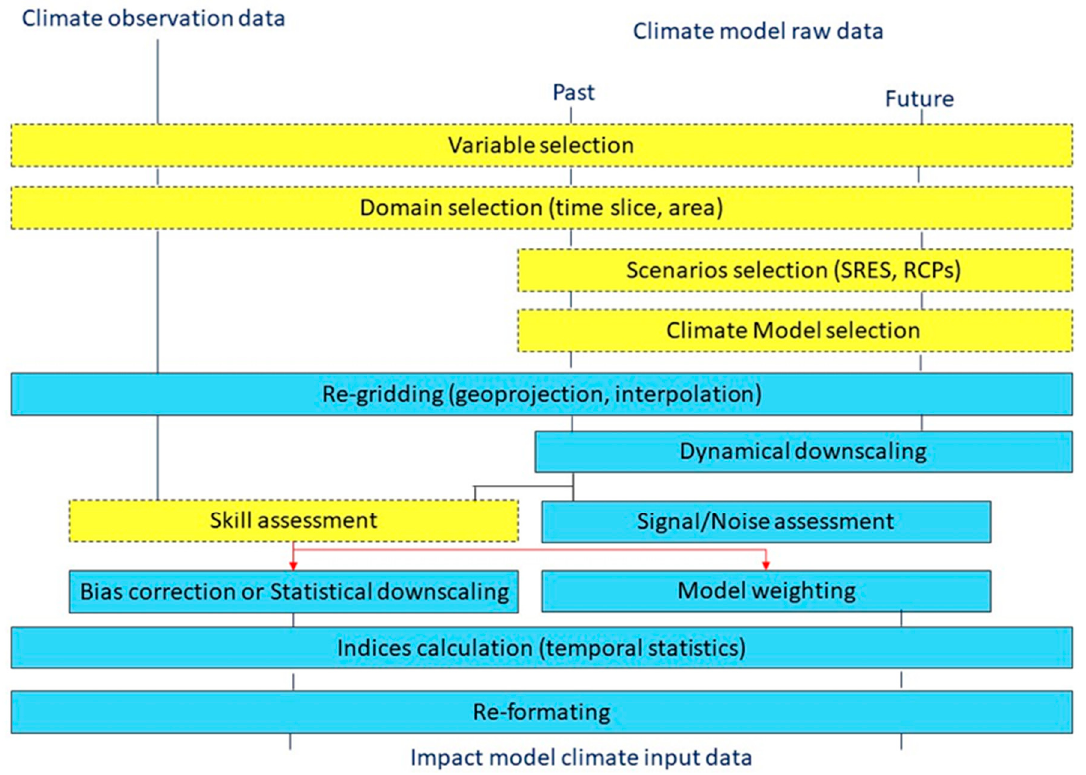
Figure 3. Steps required to assess CC impacts (adapted IS-ENES, 2019). Legend. Yellow boxes—crucial steps; blue boxes—optional steps.